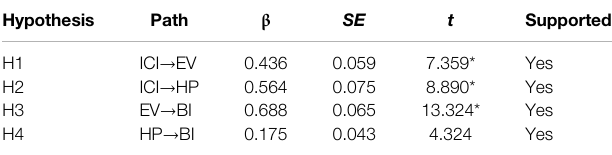
TABLE 6 | Coef fi cients of the hypothesized